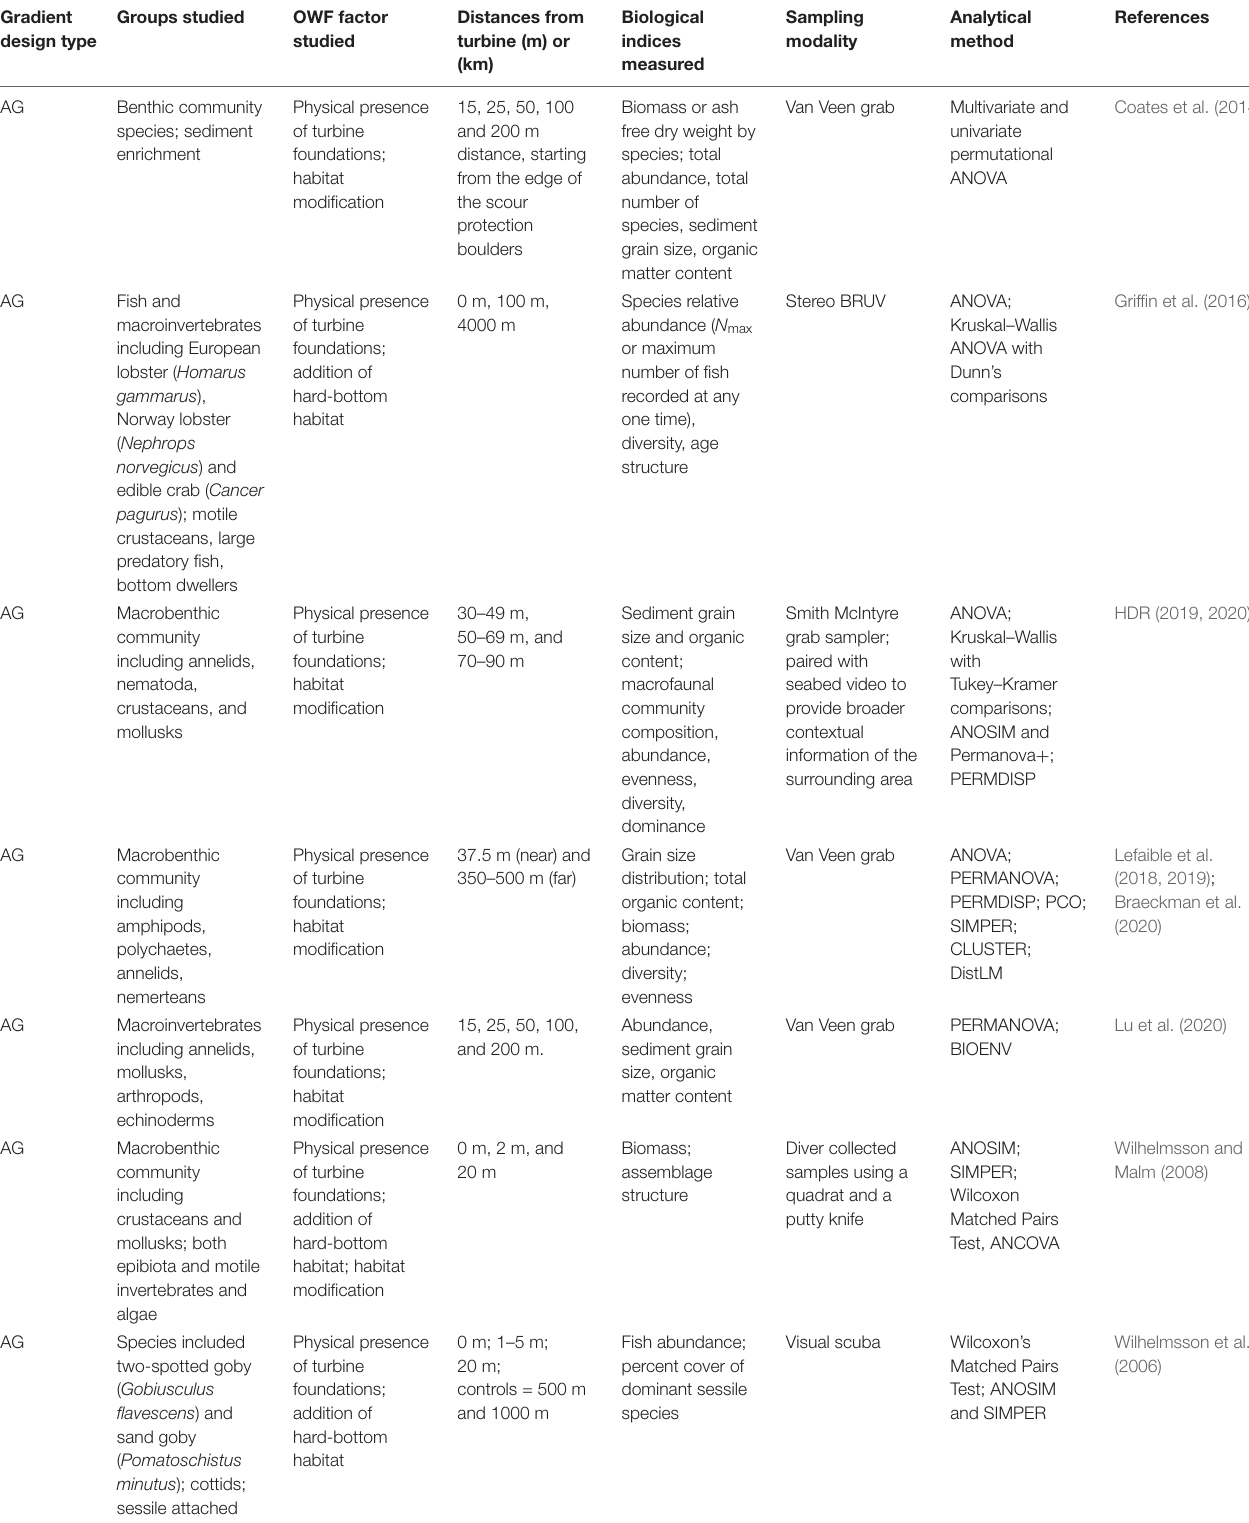
TABLE 2 | Studies of benthic invertebrates that used a gradient design to examine the effects of OWF development. Gradient Groups design type